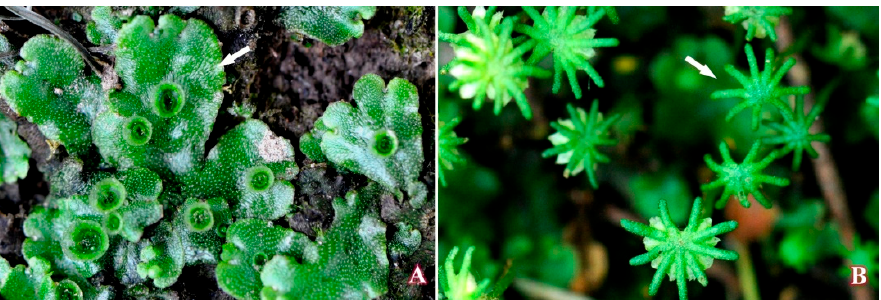
Figure 13. Gametophyte ( A ) and archegoniophore ( B ) of M. polymorpha L .